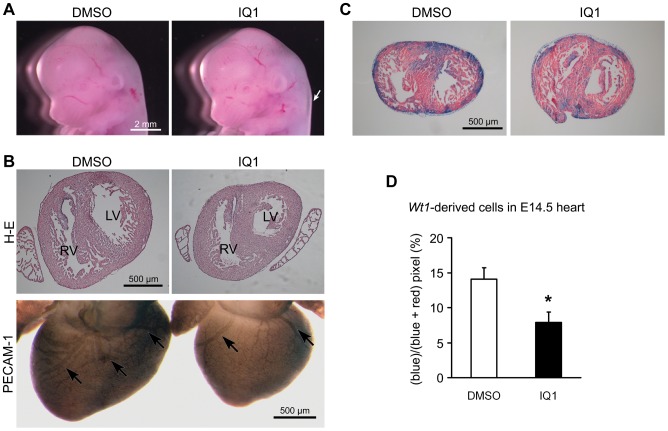
Effects of IQ1 on mouse embryonic hearts.(A) Mouse embryos were exposed to IQ1 from E12.5 to E13.5 in utero. Edematous skin is observed in IQ1 treated embryos (arrow). (B) Embryos were exposed to IQ1 from E12.5 to E16.5. IQ1 reduced the size of the embryonic hearts, size of ventricular spaces and number of trabeculae in the ventricles in transverse H-E sections (top). Whole mount PECAM-1 immunostaining shows the coronary vascular network from a dorsal view of the hearts (arrows, bottom). IQ1 decreased the number of blood vessels. LV; left ventricle, RV; right ventricle. (C) Mouse embryos were exposed to IQ1 from E12.5 to E14.5 in utero. β-galactosidase activity (blue) shows Wt1-derived cells in transverse heart sections. Nuclei were counterstained with Nuclear Fast Red. (D) Wt1
-derived cells were quantified by blue pixels. IQ1 treatment decreased Wt1-derived cells in mouse embryonic hearts significantly. *P = 0.0197. Data are presented as mean ± s.e.m.